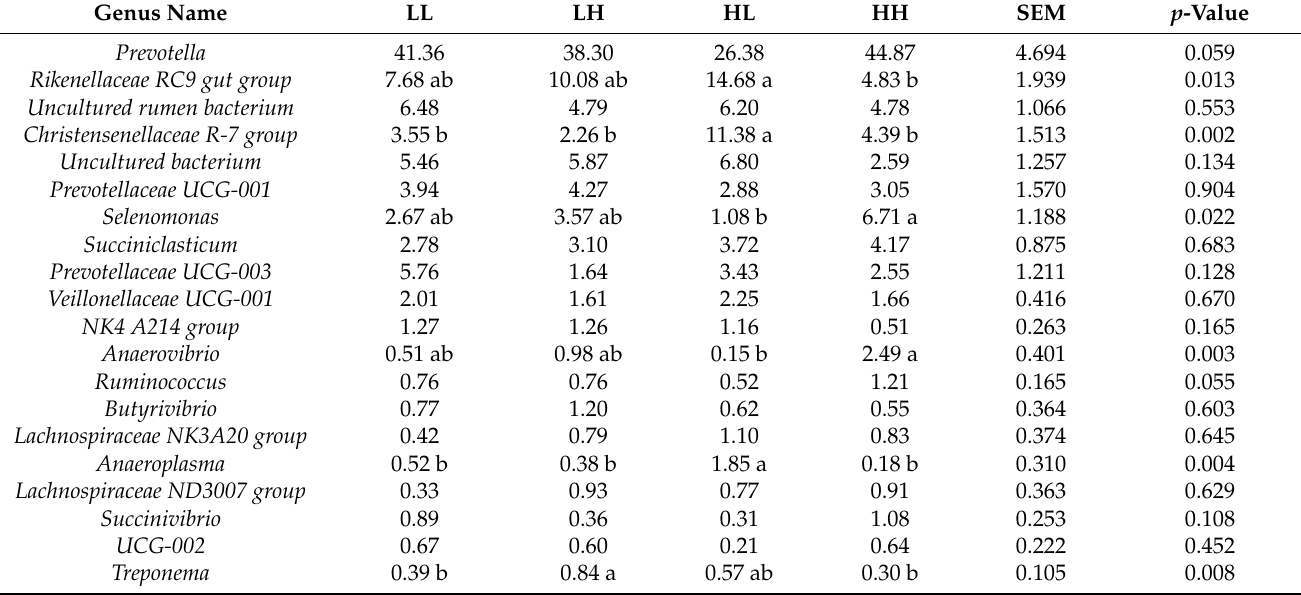
Table 5. Effect of the energy provision strategy on the rumen bacterial composition of Hu sheep at the level of genus